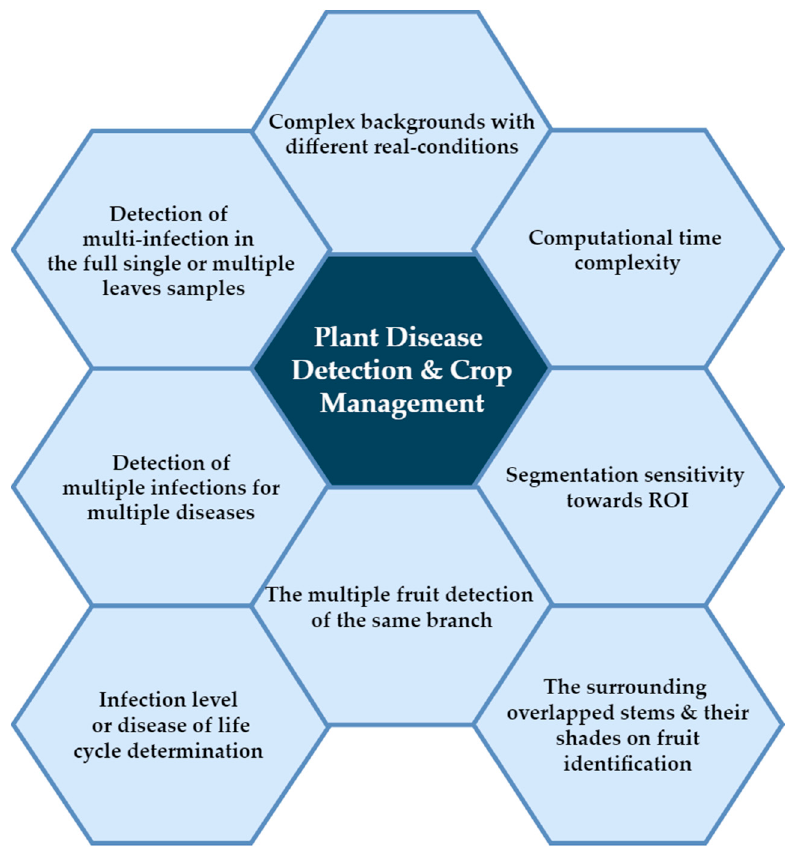
Figure 1. The current challenges of plant disease detection and crop management.